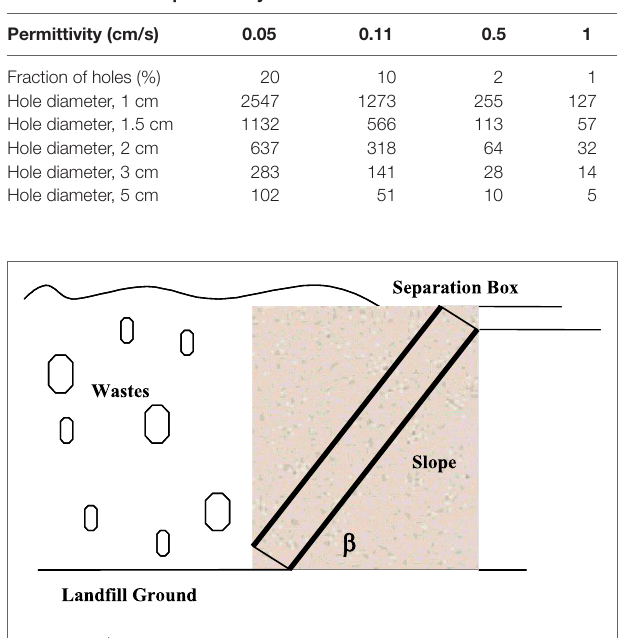
FigUre 6 | schematic diagram of waste landfill slope with geosynthetic separation box .